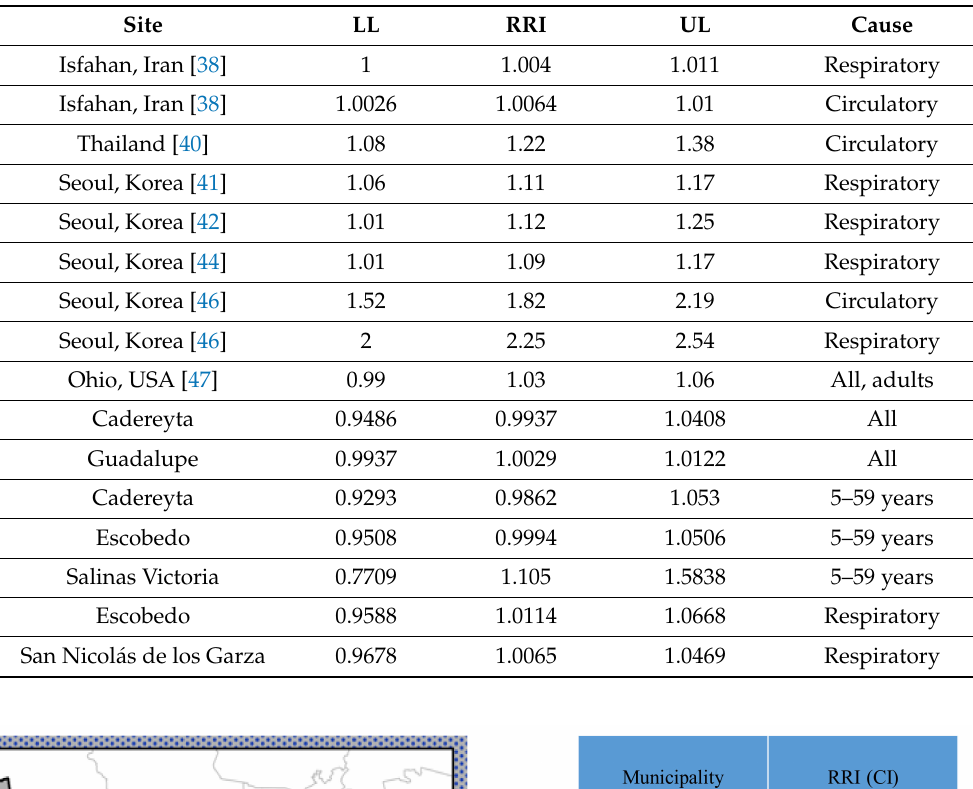
Table 7. RRI, lower and upper limit values found in MAM for SO 2 during the study period, and comparison with values reported by other studies around the world.